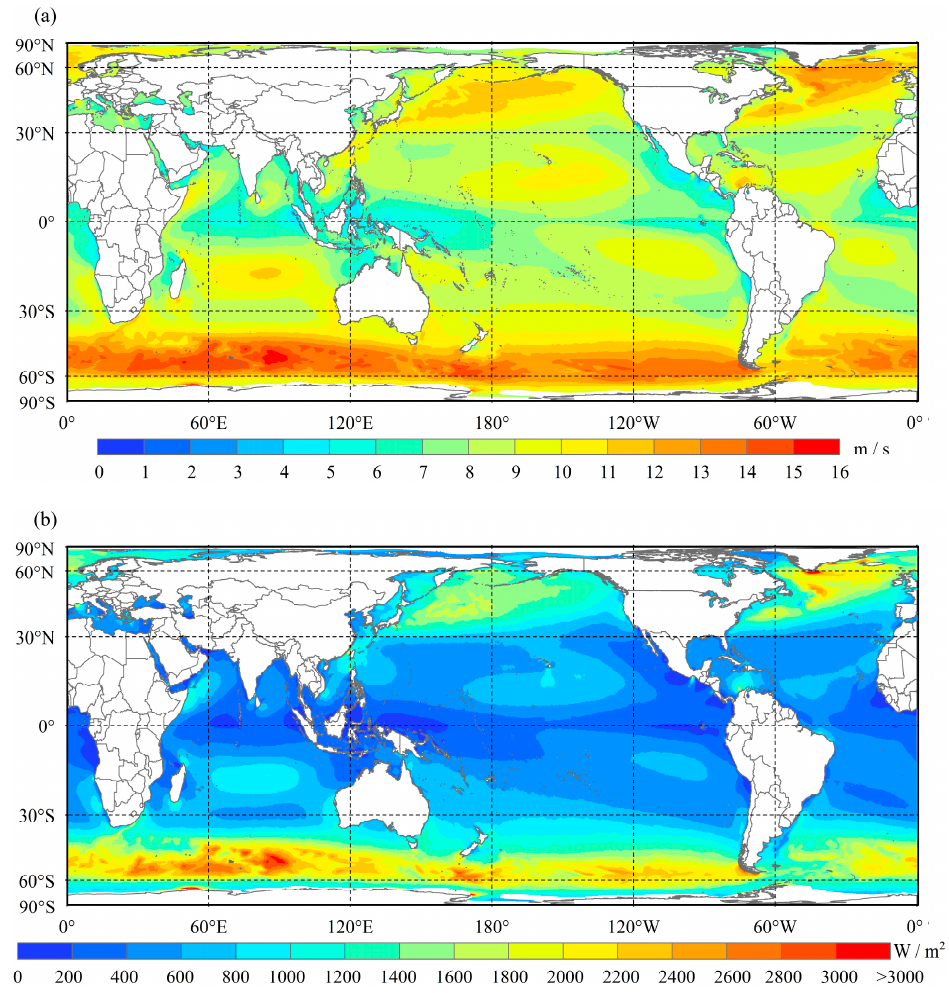
Figure 5. The distribution of global MWS and WPD at 100 m above sea level derived from QuikSCAT + WindSAT + ASCAT during the period 1999–2015. ( a ) MWS, and ( b ) WPD.